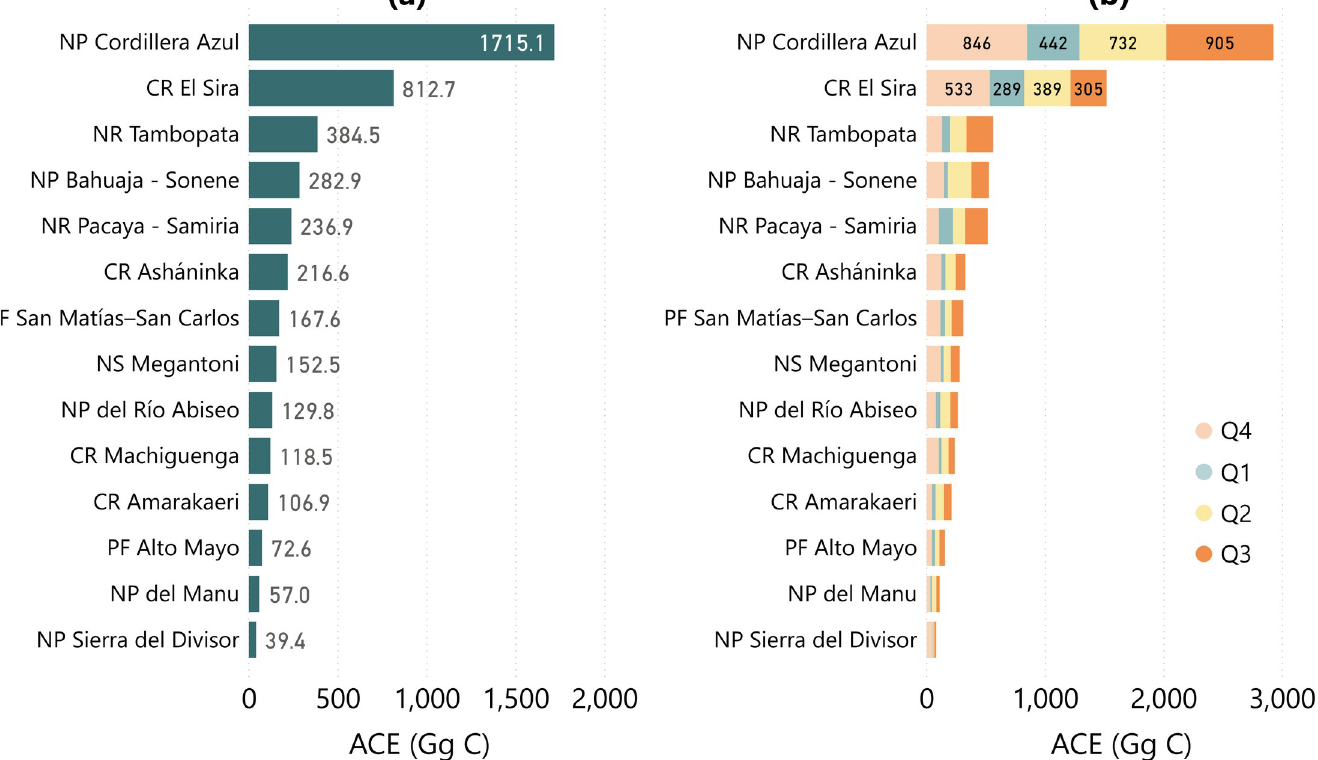
PLOS ONE | https://doi.org/10.1371/journal.pone.0241418 November2,